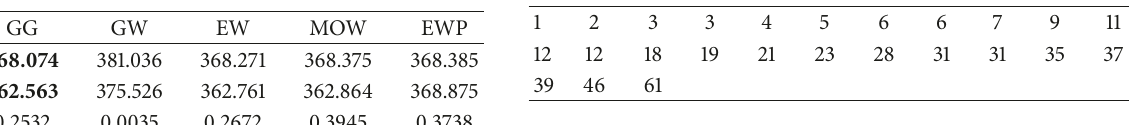
Table 11: Dataset related to the sugarcane harvester’s transmission B.